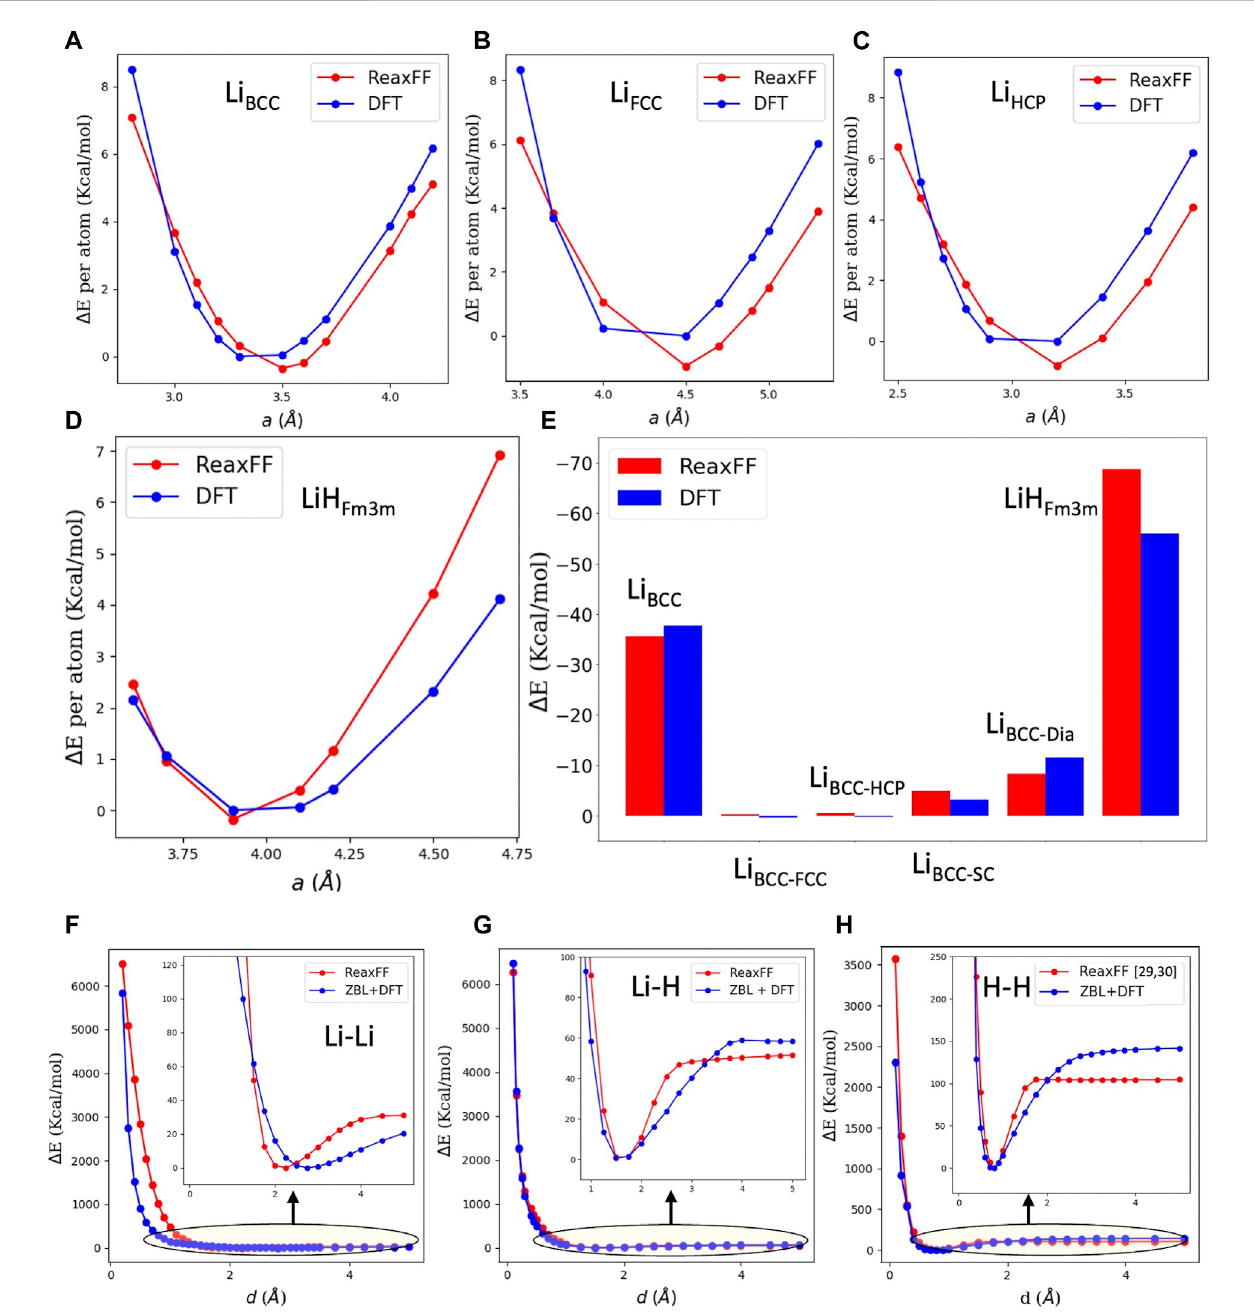
FIGURE 2 Comparison between DFT and ReaxFF force fi eld used in present study. (A – D) Potential energy curves for Li metal lattices, i.e., BCC, FCC, HCP, and for the LiH Fm3m-lattice, obtained by DFT calculations and by ReaxFF. (E) Cohesive energy of the Li BCC lattice, formation energy of the LiH Fm3m-lattice, and relativestability oftheLiBCC-lattice totheLiFCC,HCP, SC,and Dia-lattices. (F – H) Li-Li,L-H,and H-Hdiatomic potentials. In (A – D) and (F – H) ,theminimum energy from the DFT calculation is chosen as zero energy, hence Δ E = Energy – min (E DFT )